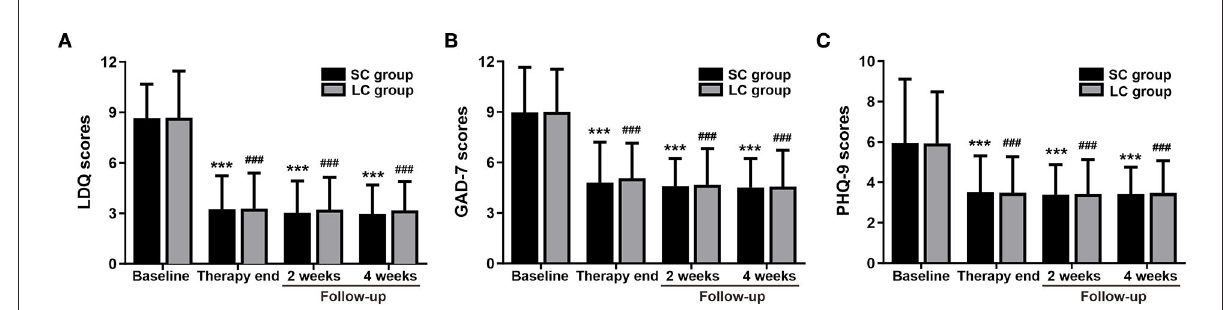
FIGURE3 Treatment outcomes of patients with refractory functional dyspepsia receiving 2- or 4-week FM treatment. (A) LDQ scores, (B) GAD-7 scores, and (C) PHQ-9 scores in SC group ( n = 110) and LC group ( n = 109). SC, short-course; LC, long-course; LDQ, Leeds Dyspepsia Questionnaire;